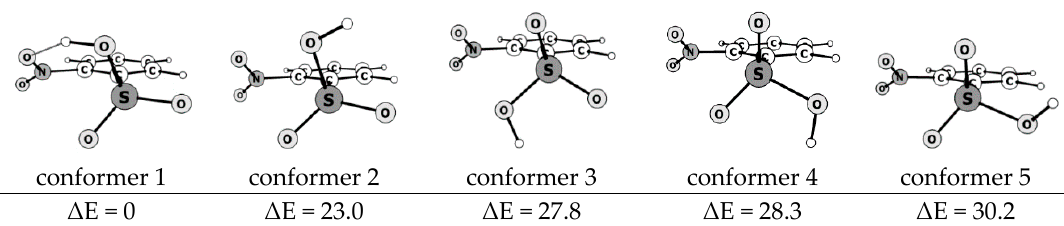
Figure 2. The structure of the 2-NO 2 -BSA conformers and their relative energies (kJ mol − 1 ).